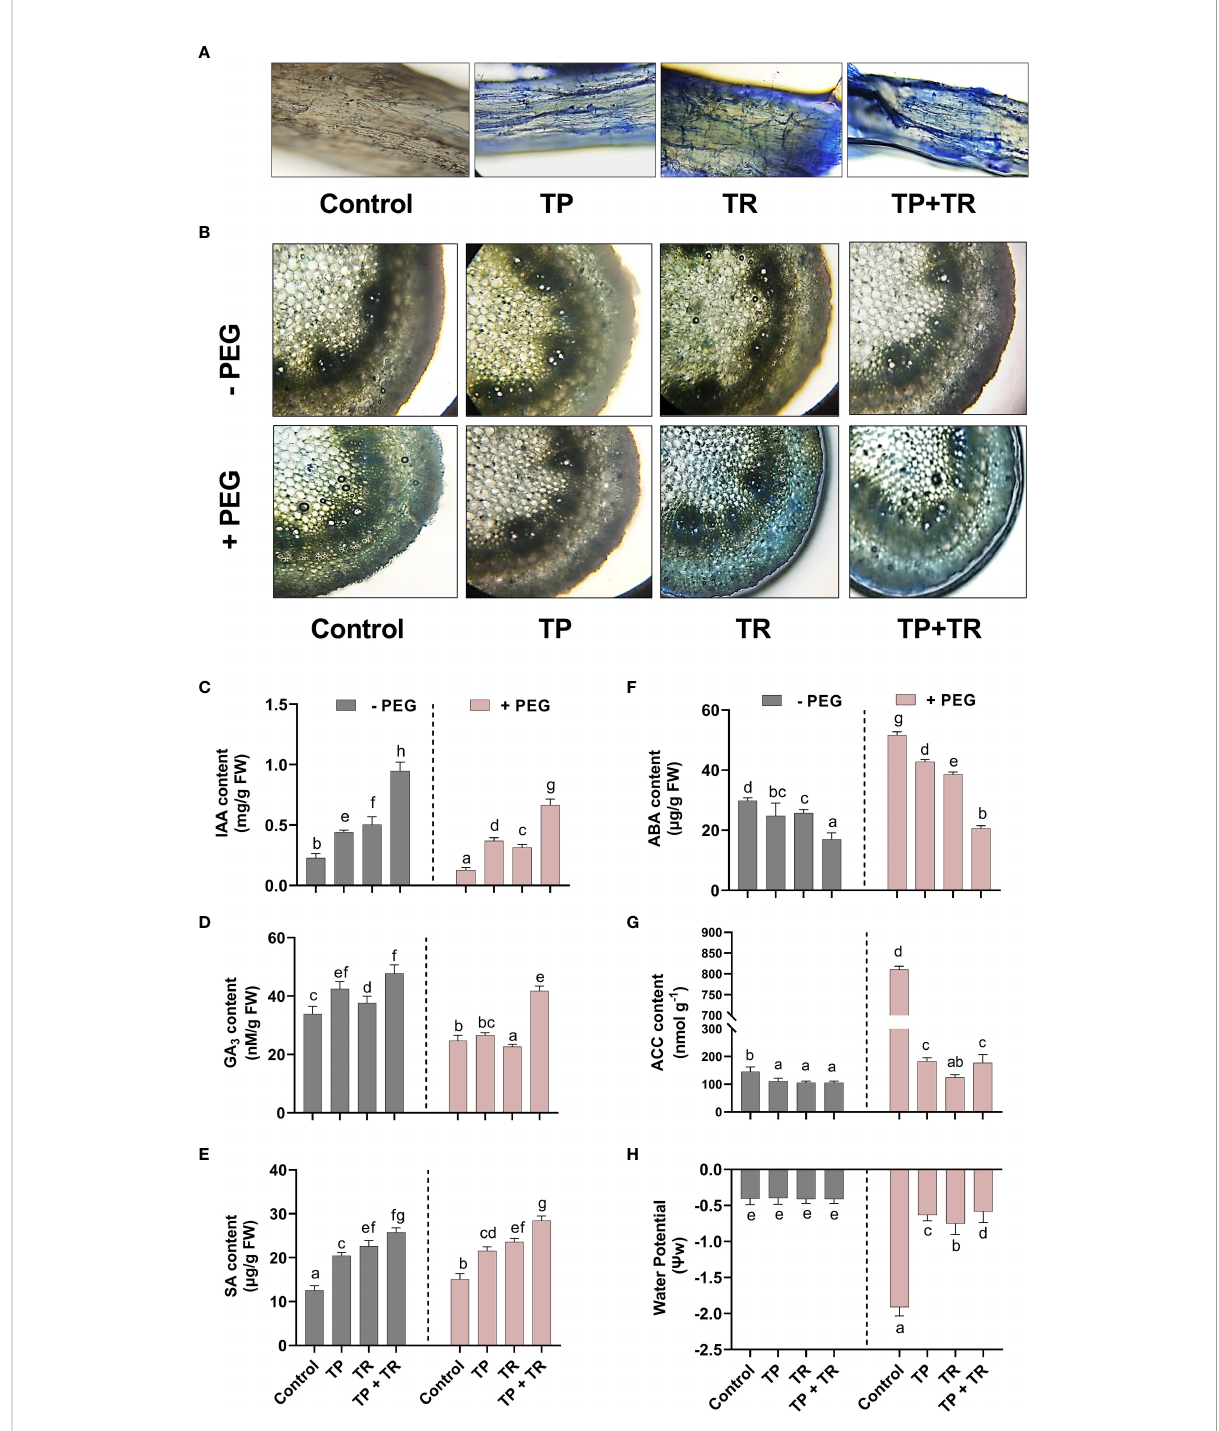
FIGURE 7 Effect of TP and TR inoculation and colonization in M. oleifera phytohormones and water potential. (A) Root colonization, (B) Stem anatomy, (C) IAA, (D) GA 3 , (E) SA, (F) ABA, (G) ACC content and, (H) Water potential. Quantitative data is representing the means ± SE values of at least three independent biological replications. Various letters have been presented to show the statistical differences at signi fi cance level of p¾ 0.05 using Duncan ’ s Multiple Range Test